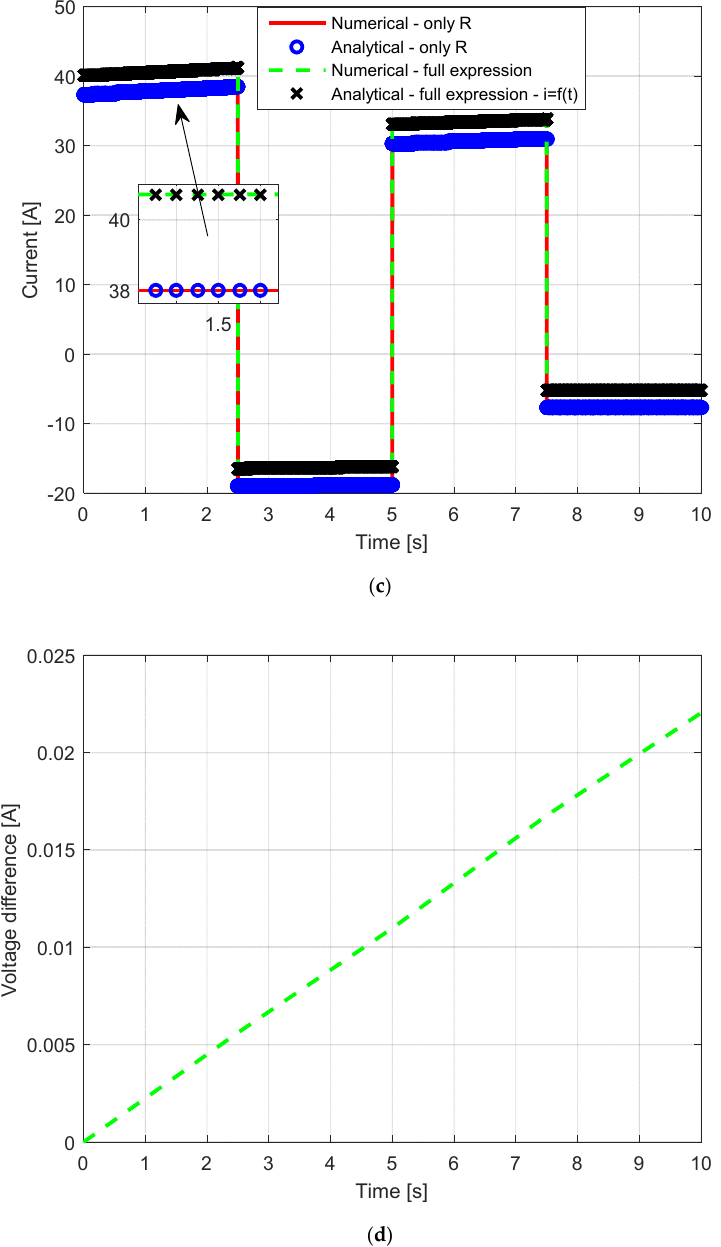
Figure 10. Results obtained by using the derived expressions and those obtained by using the expressions presented in [27]: ( a ) successive power changes versus time; ( b ) voltage versus time; ( c ) current versus time; ( d ) difference between voltage calculated using the methods investigated; C = 1200 F, R b = 1 Ω , and R = 0.58 m Ω .